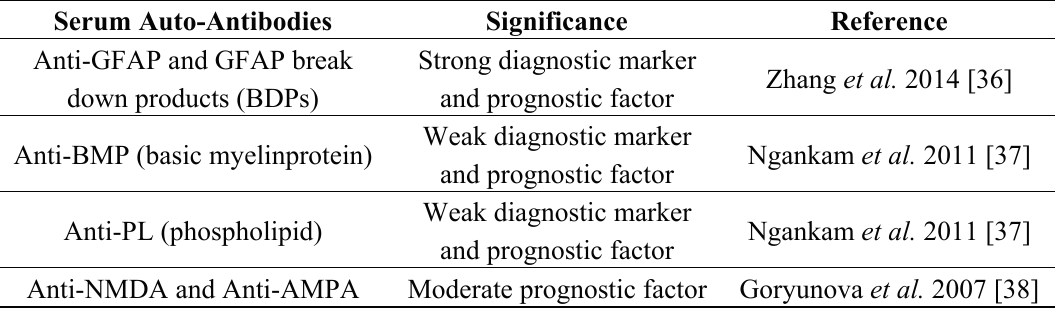
Table 1. Auto-antibodies as diagnostic marker and/or prognostic factor in traumatic brain injuries